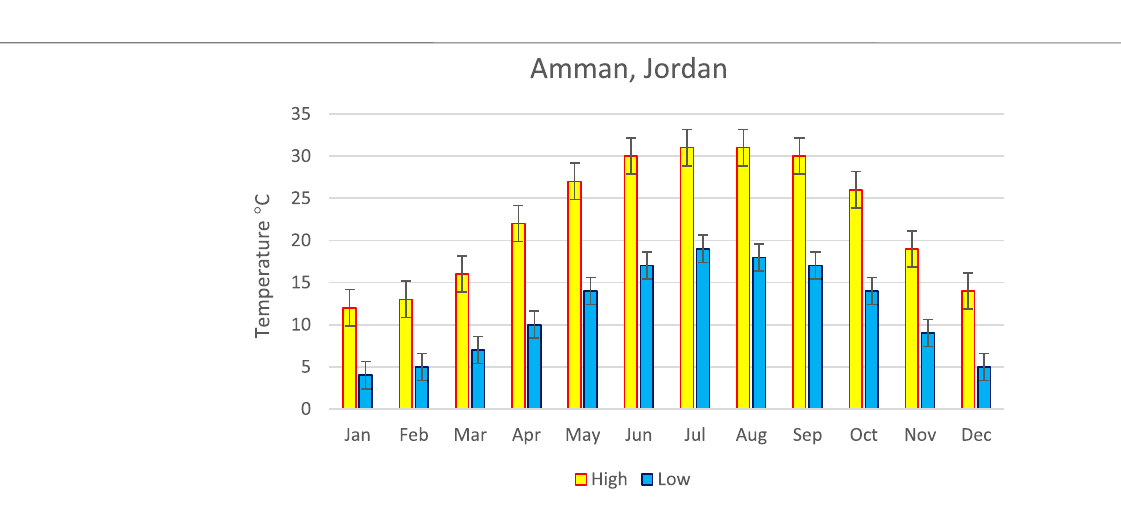
FIGURE 2 | The average temperature in the Jordanian capital Amman throughout the year, with its upper and lower